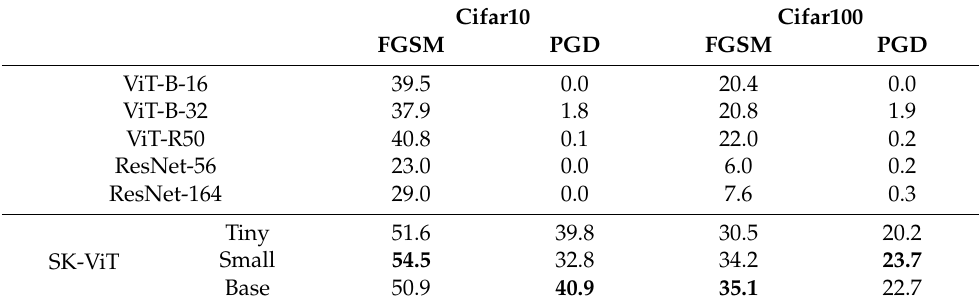
Table 7. Experimental results of Cifar10 and Cifar100